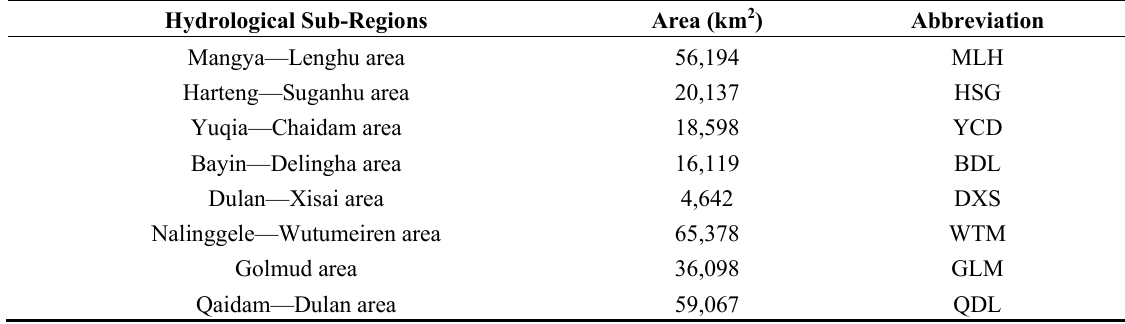
Table 1. Areas and abbreviations of hydrological sub-regions in the Qaidam Basin. Hydrological Sub-Regions Area (km 2 )